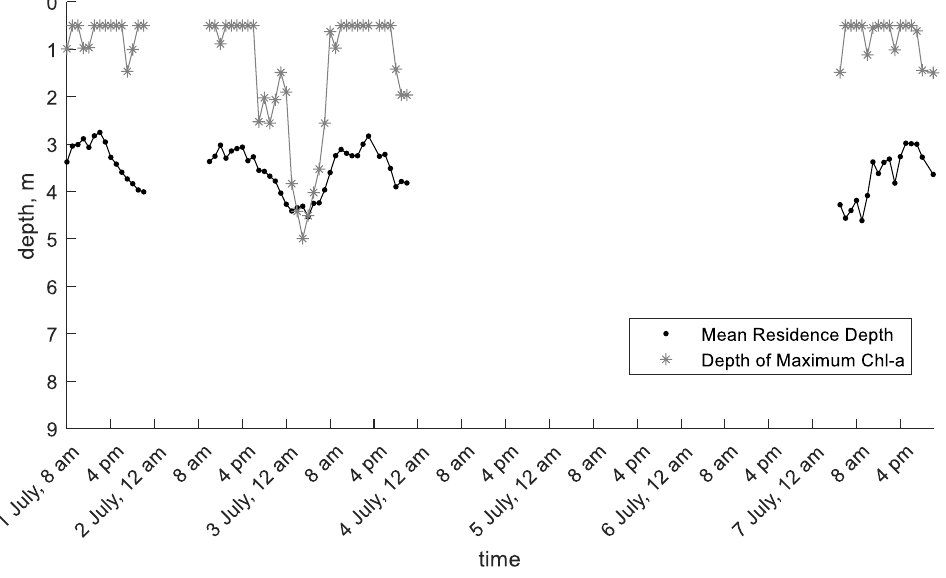
Figure 4. Mean residence depth and depth of maximum chlorophyll a calculated from chlorophyll a measurements taken in Xiangxi Bay; data extracted from Wang et al. [49].